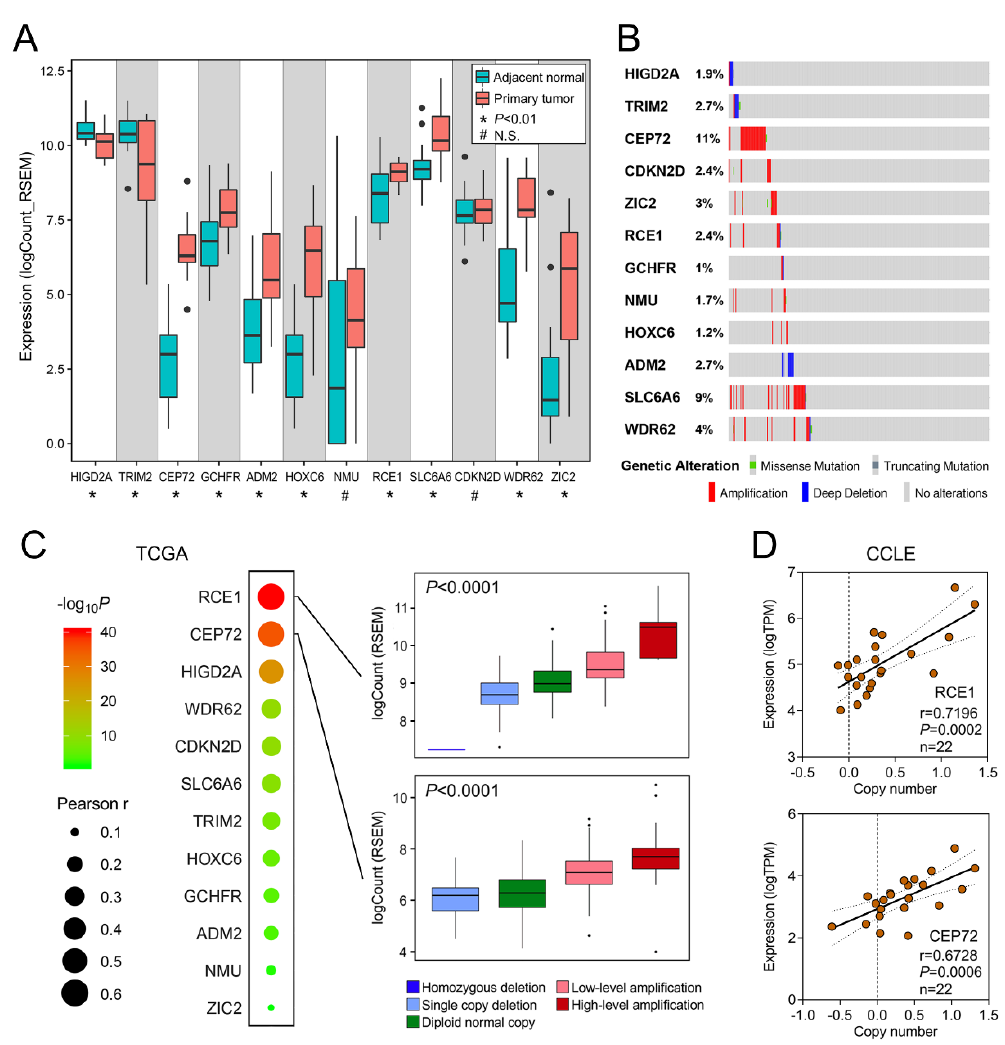
Figure 5. Copy number alteration is closely correlated with dysregulated expression of the gene signature. ( A ) Most genes (10 / 12) involved in the gene signature were dysregulated in 19 paired BCa and adjacent normal tissues from The Cancer Genome Atlas (TCGA). ( B ) An Oncoprint was plotted to visualize the genomic alterations including mutation and copy number alteration of the gene signature in 413 TCGA BCa samples. ( C ) Overview of relationships between copy number and mRNA expression is plotted. Bubble size represents Pearson correlation coe ffi cient, and color presents the significance. Two representative genes RCE1 and CEP72 with r > 0.5 are shown in detail. ( D ) Copy numbers of RCE1 and CEP72 were frequently amplified in most BCa cell lines, and highly positive correlation between copy number and mRNA expression of RCE1 (r = 0.7196, p = 0.0002) and CEP72 (r = 0.6728, p = 0.0006) was observed in 22 BCa cell lines. * p < 0.01; N.S., no